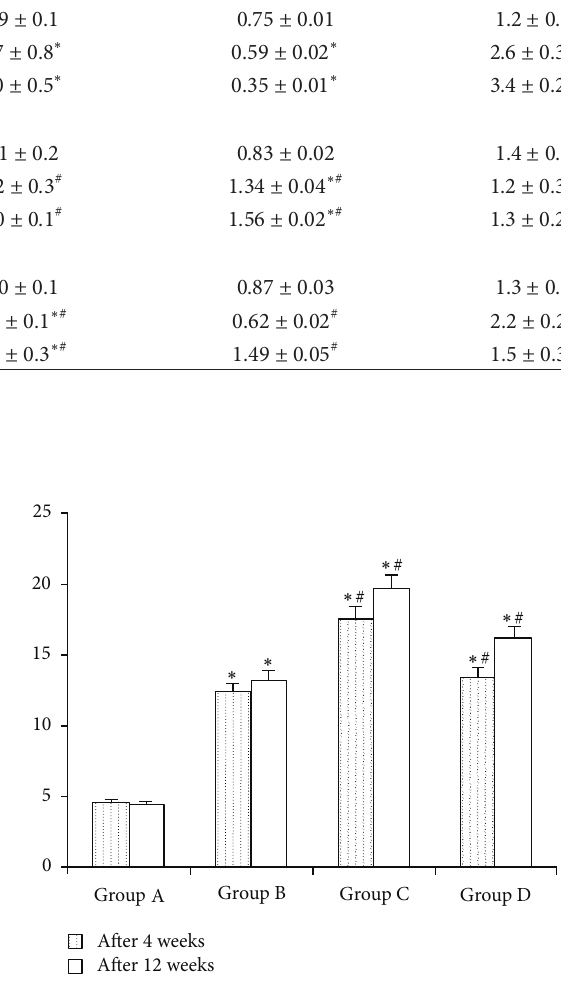
FPG levels of various